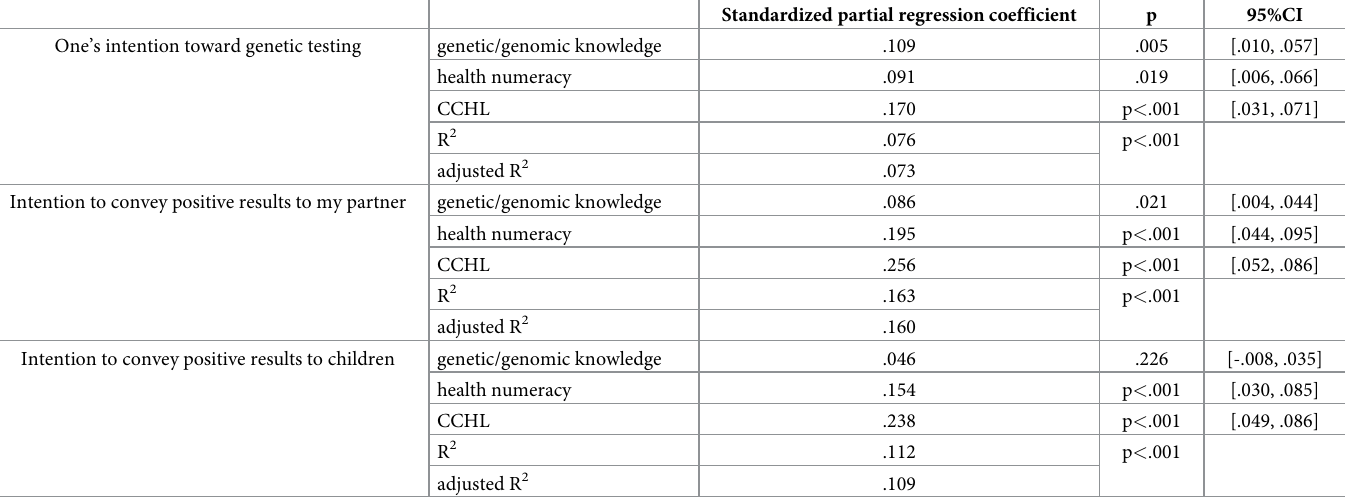
Table 4. Multiple regression analysis with behavioral intention as the dependent